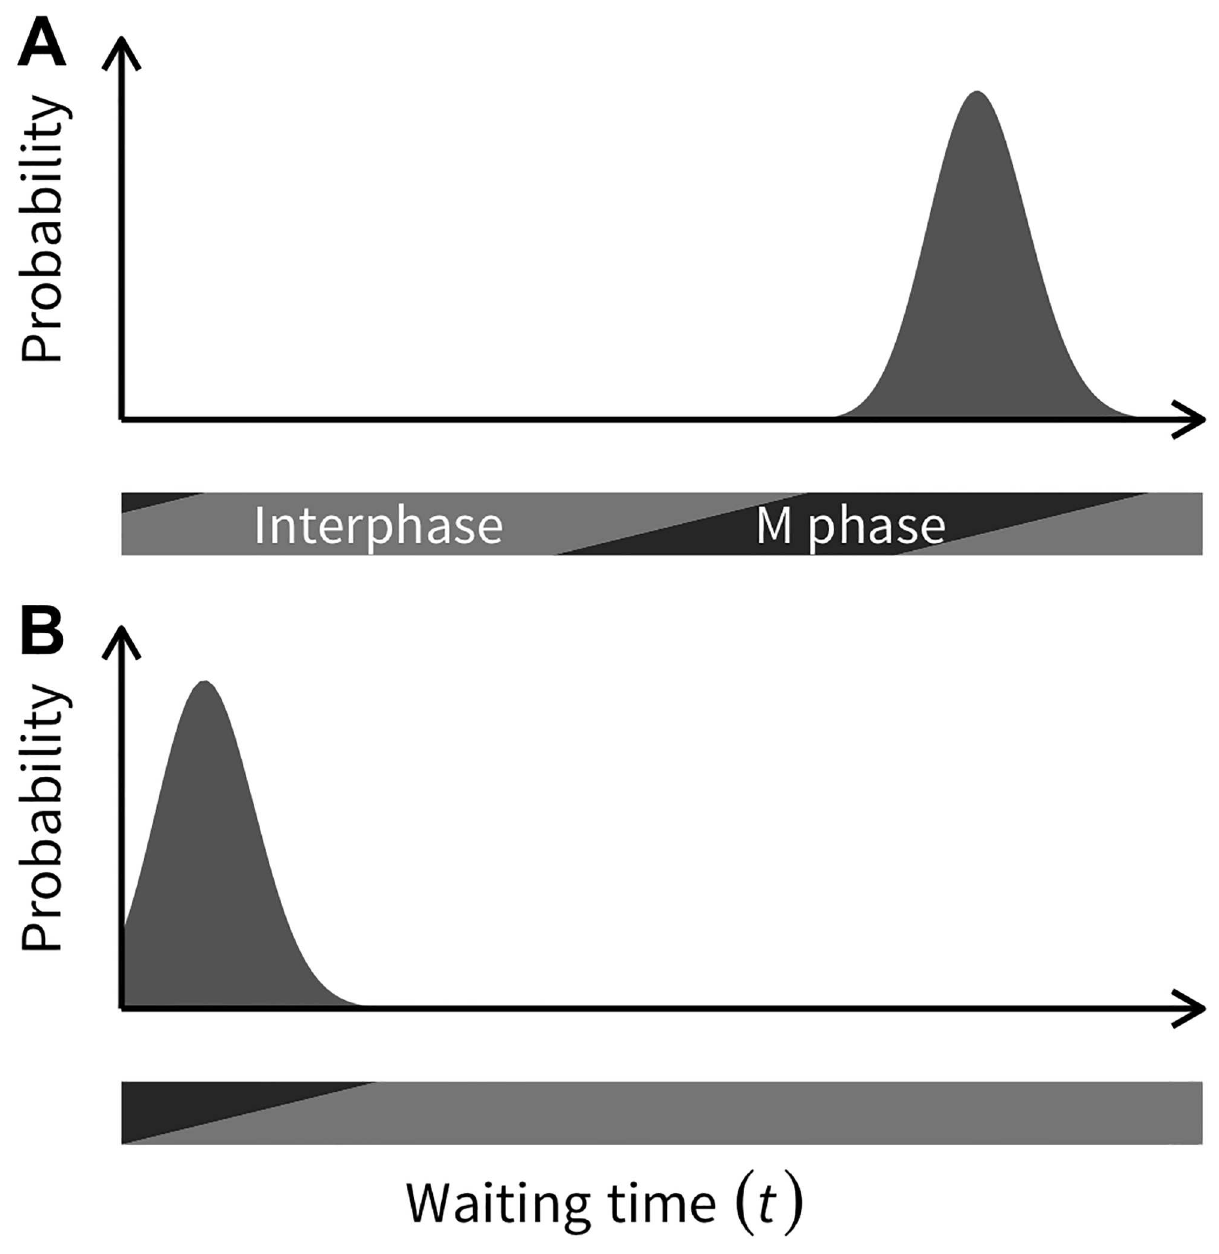
Fig 4. Illustrating the biological background behind using a gamma distribution with a reasonably large k . When a cell undergoes division, its daughtercells should enter interphase, duringwhich they preparefor the next cell division,and it should be difficult to predict a cell divisionin early interphase(see text for